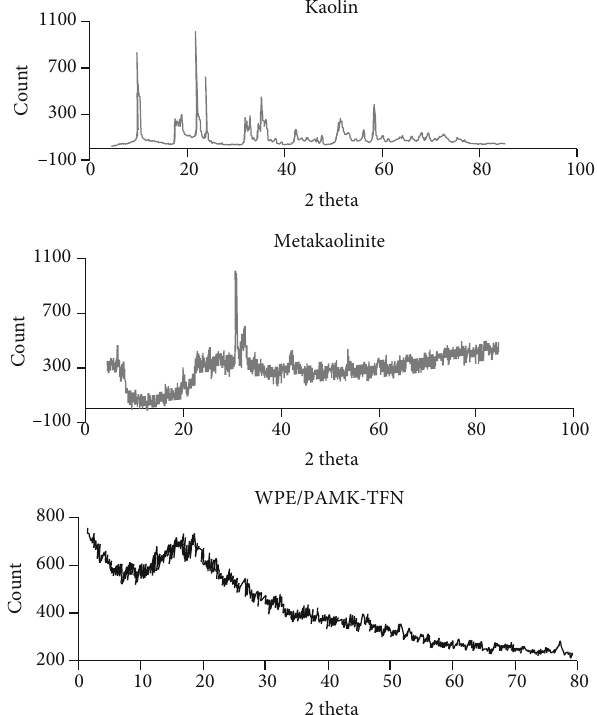
Figure 5: The results of XRD analysis of kaolin, metakaolin, and WPE/PAMK-TFN